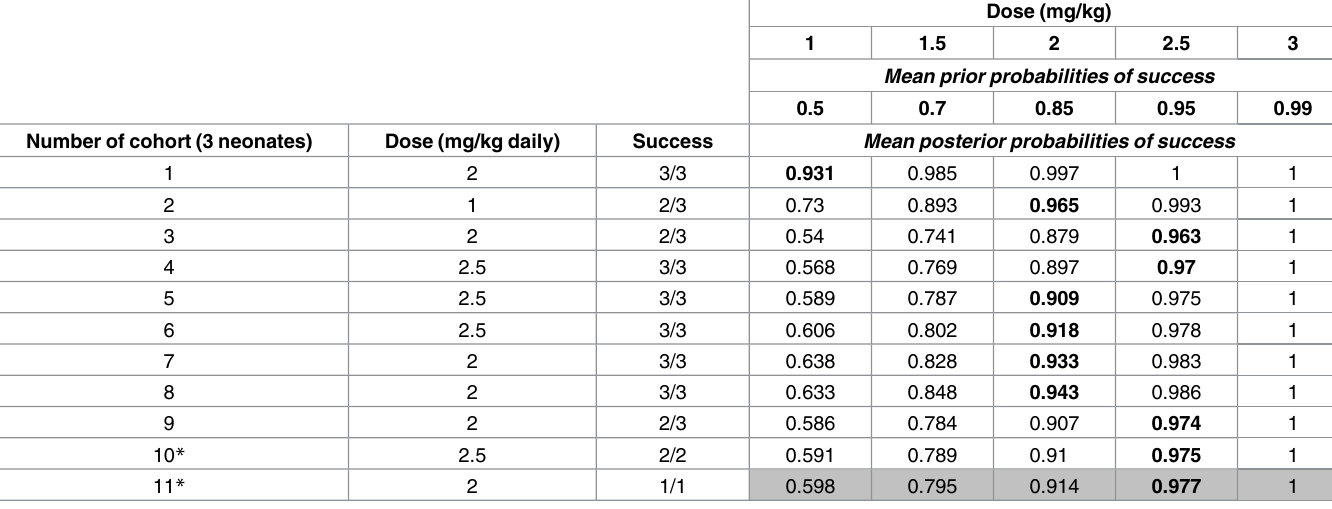
Bold characters indicate the estimations of the minimum efficient dose after the inclusion of each cohort. Mean posterior probabilitiesof success for each dose are highlightedin